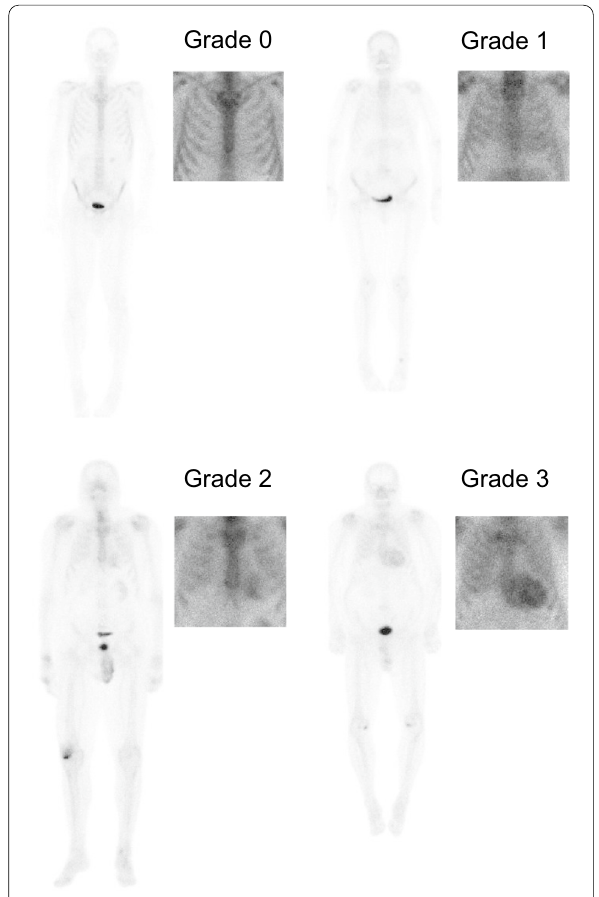
Fig. 1 Whole‑body and cropped bone scintigraphy images of patients with different Perugini grades of cardiac uptake